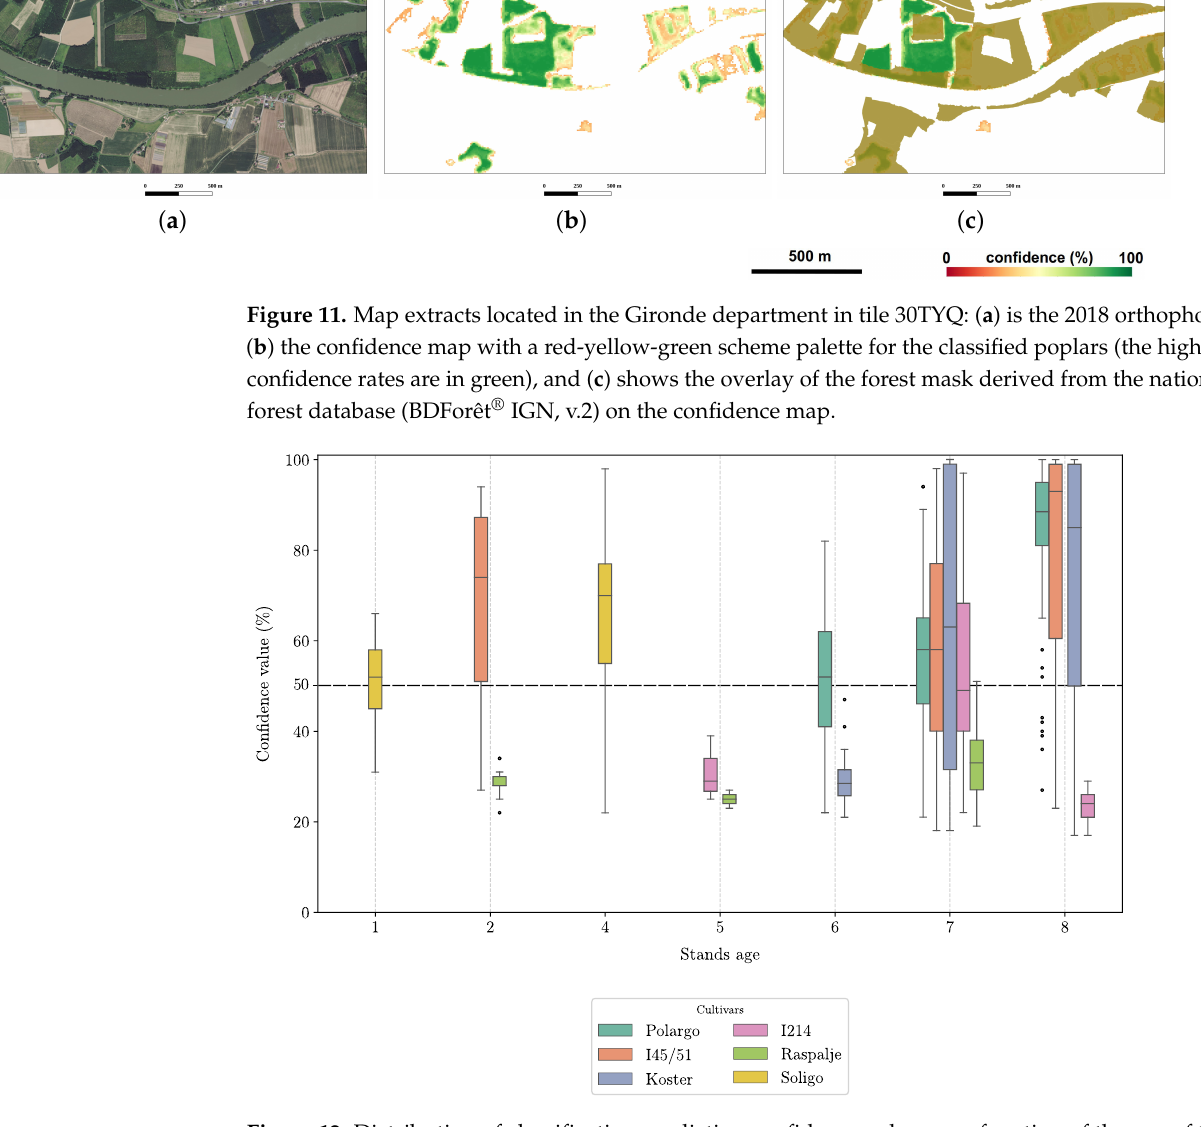
Figure 12. Distribution of classification prediction confidence values as a function of the age of the detected plantations and of the cultivar planted. These values were extracted from 85 field-checked plots provided by the forest partners located in the Lot-et-Garonne department in southwest France (S2 30TYQ image